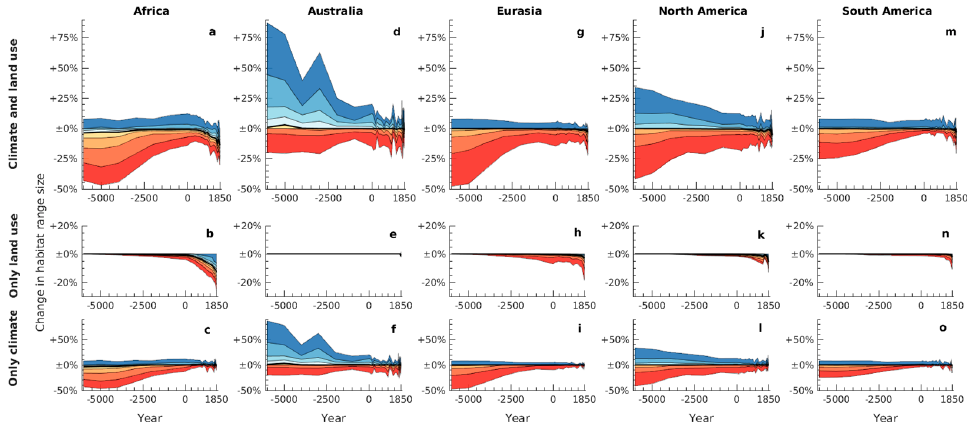
Figure 4. Estimated changes in range sizes over time, relative to potential natural ranges in 1850, depending on species’ primary geographical region. The top ( a , d , g , j , m ), middle ( b , e , h , k , n ), and bottom ( c , f , i , l , o ) panels in each column are analogous to Figure 2a–c, respectively, but represent only species with the relevant primary